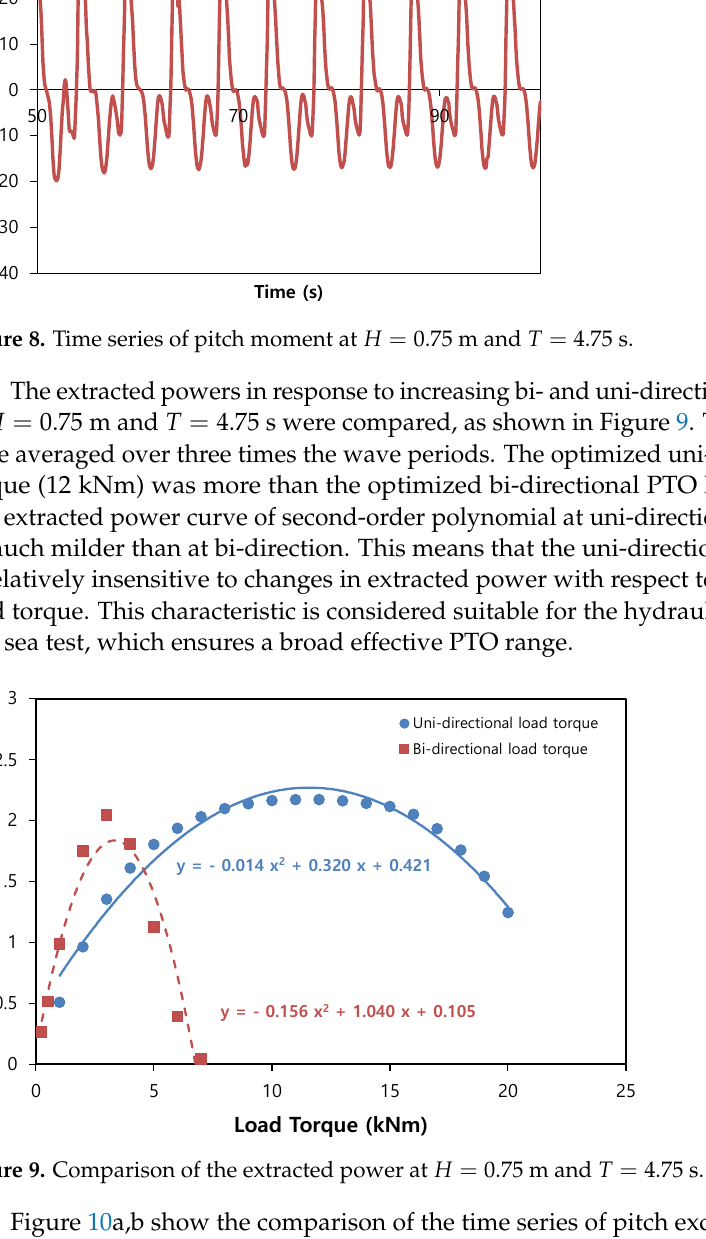
Figure 9. Comparison of the extracted power at H = 0.75 m and T = 4.75 s. Figure 10a,b show the comparison of the time series of pitch excursion (top), angular velocity (middle), and the extracted power (bottom) at H = 0.75 m and T = 4.75 s between bi- and uni-directional PTO load torque of 5 kNm. Additionally, the time-averaged power over the three wave periods was included in the time series of extracted power. The restoring moment of the asymmetric WEC depends on its weight; however, the bi- directional PTO load torque system suppresses it to prevent the asymmetric WEC from being restored to its rest position (beak angle of 65°). Therefore, the pitch excursion with bi-directional PTO load torque is less than uni-directional PTO load torque because the asymmetric WEC absorbs the wave force in non-optimal conditions. The time series of angular velocity with bi-directional PTO load torque shows that the positive and negative constant PTO load torque oscillates rapidly near an inflection point because the total mo- ment from flow and gravity is less than the constant PTO load torque. The uni-directional PTO load torque harnesses only half of the wave energy; however, the extracted power is larger because the PTO load torque is greater than the optimum PTO torque in the bi- directional case (5 Nm). ( a ) ( b ) Figure 10. Comparison of the time series of pitch excursion (top), angular velocity (middle), and the extracted power (bottom) at 𝐻 = 0.75 m and 𝑇 = 4.75 s. ( a ) Bi-directional PTO load torque of 5 kNm and ( b ) uni-directional PTO load torque of 5 kNm.